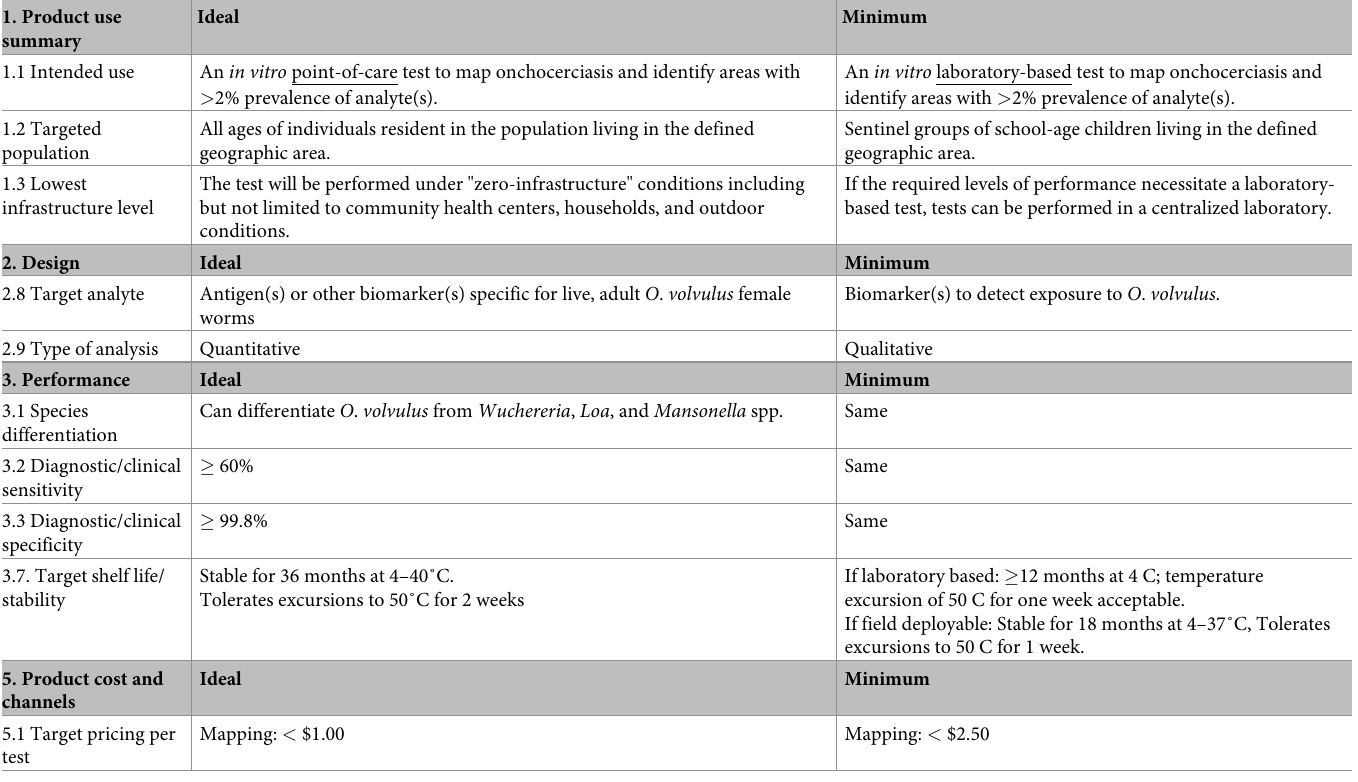
Table 1. Selected features of the target product profile of a diagnostic to map onchocerciasis in low prevalence areas. Criteria that are generally expected of a rapid diagnostic test for a NTD are not included in this summary. For all 41 criteria, please see the original publication [5]. The word “biomarker” includes an